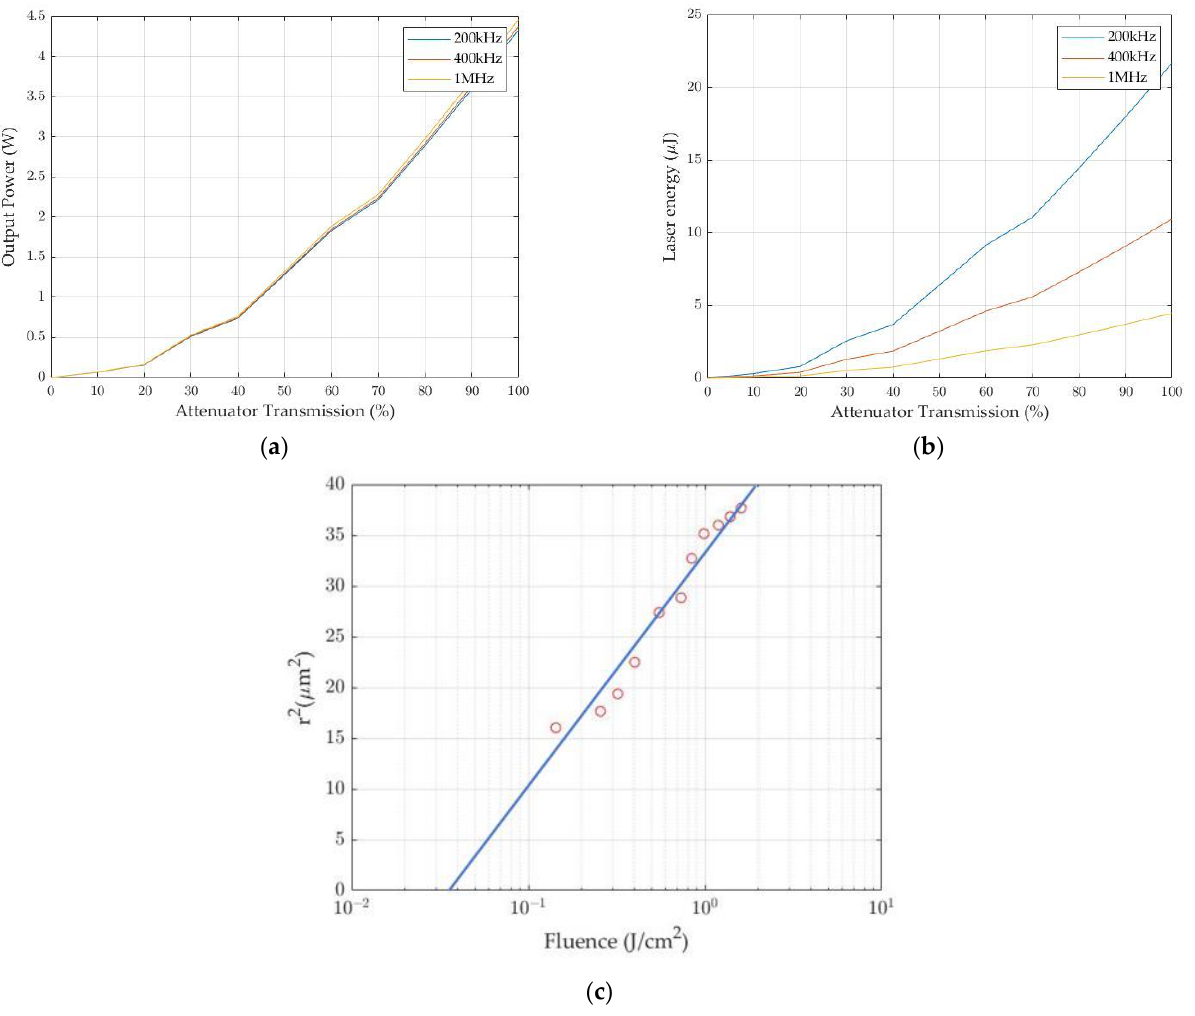
Figure 11. ( a ) Output laser power, ( b ) laser energy, and ( c ) ablation threshold plot for silicon using laser fluences of F = 0.165 µJ/cm 2 – 1.884 µJ/cm 2 in the attenuator transmission range of 20% to 65%.